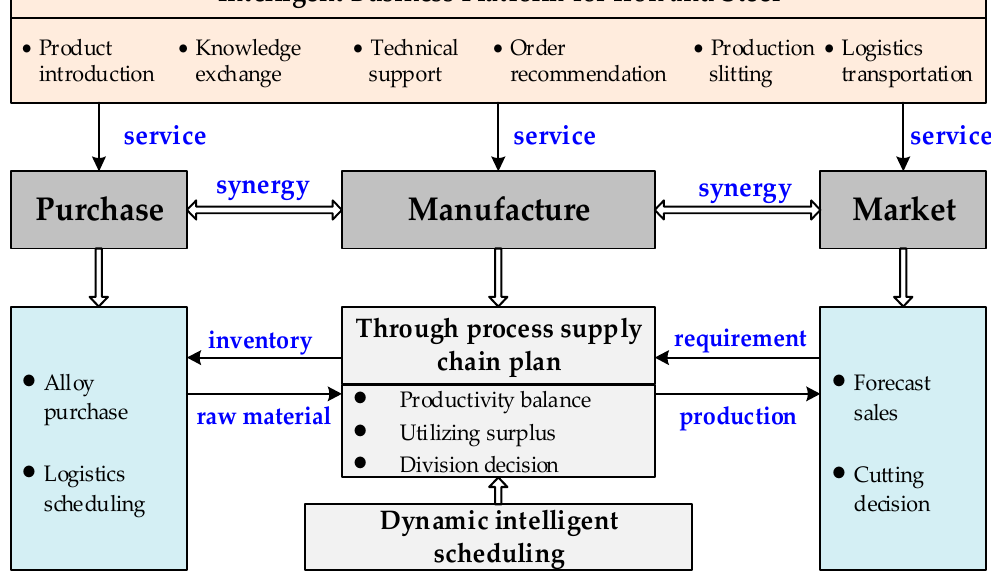
Figure 1. Collaborative intelligent optimization decision of steel strip purchasing, marketing and manufacturing supply chain.